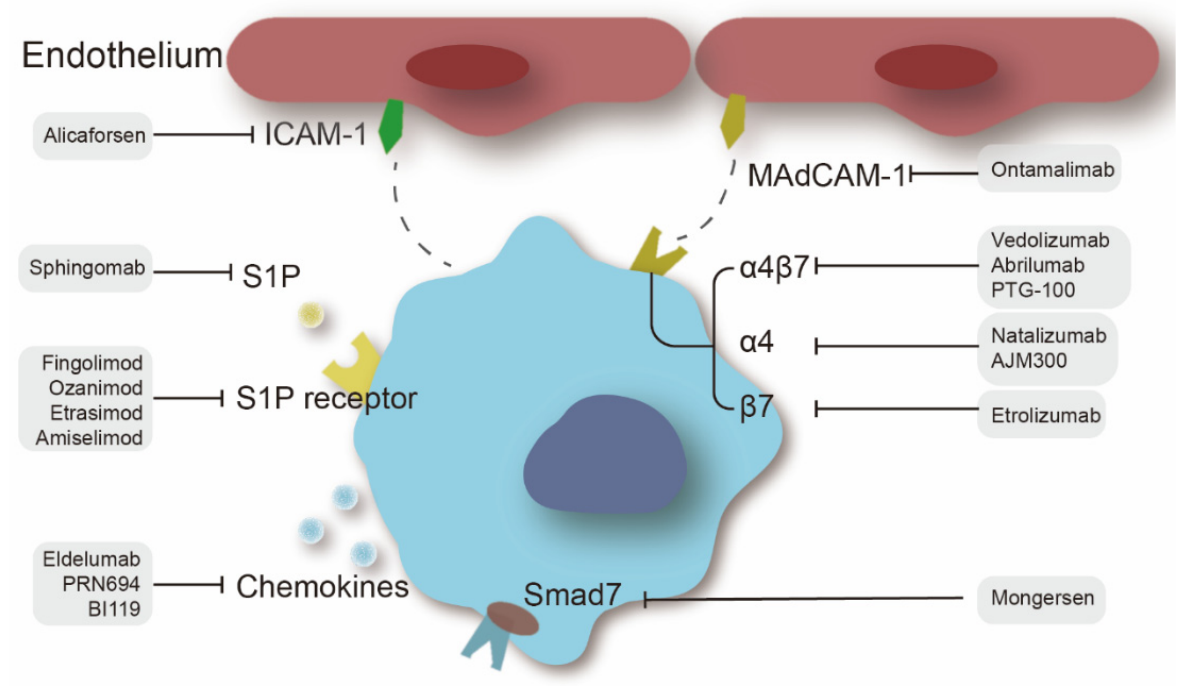
Figure 3. Therapeutic targets of leukocyte trafficking in IBD treatment and specific therapeutic agents.